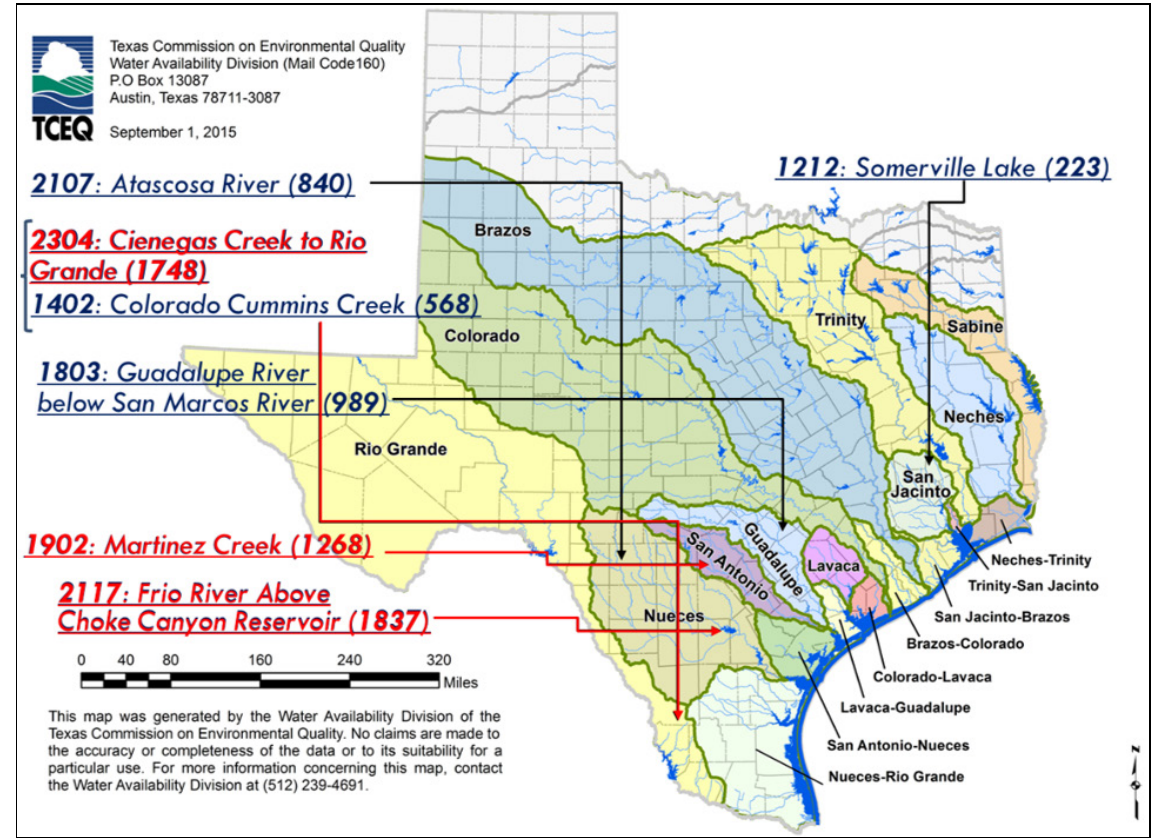
Figure 8. Map showing the produced water receiving basins which have adopted environmental inflow standards. The average reported total dissolved solids concentrations per Texas Surface Water Quality Standard 307 segments is also included with 2304, 1902, and 2117 exceeding the established segment